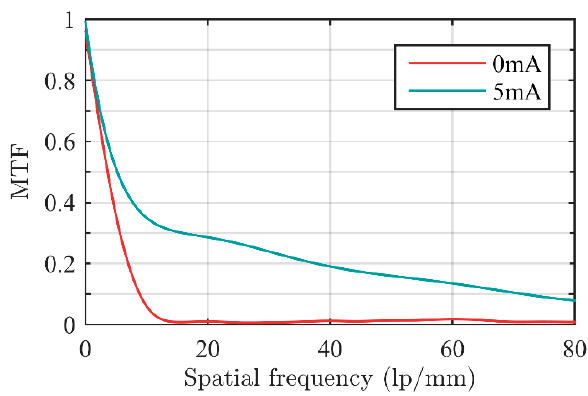
Figure 7. MTF curve of the zoom system when I 2 took 0 mA and 5 mA, respectively.